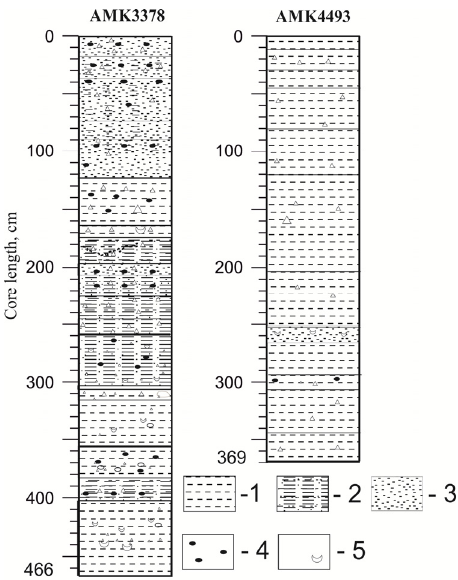
Figure 2. Lithology of the Snorri Drift core AMK-3378 and Gloria Drift core AMK-4493. (1) Pelite silt, (2) aleuropelite, (3) sand, (4) hydrotroilite, (5) calcareous detritus.